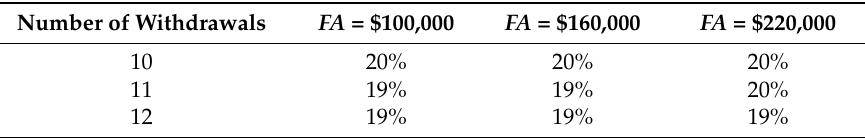
Figure 2. Income risk and legacy potential with and without LIRP. Table 3. Selected values of income risk for the case study. FA : face amount